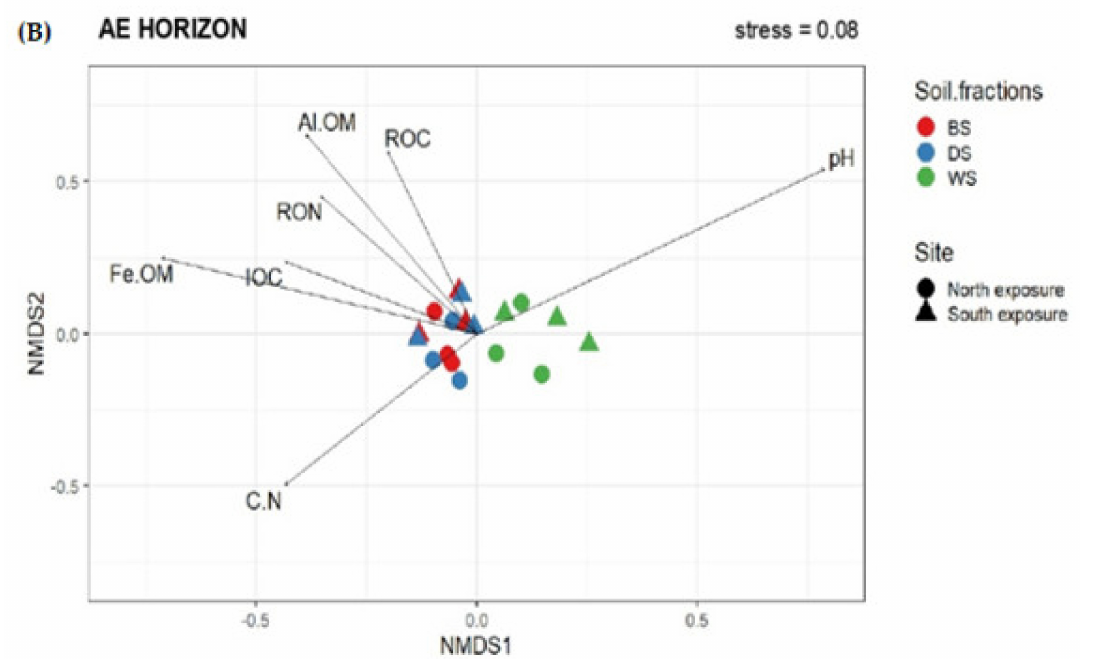
Figure 4. Nonmetric multidimensional scaling (NMDS) ordination to map the physico-chemical parameters to the shifts in organic (OF; ( A )) and mineral (AE; ( B )) horizons of microbiological properties (microbial biomass—dsDNA; and microbial activity—exDNA/iDNA ratio; and enzyme activities) as a function of slope exposure (north exposure = point symbol; south exposure = triangle symbol), and between the bulk soil (BS) and the different aggregate fractions (dry-sieved [DS] and water-stable [WS] 1.00–0.50 mm